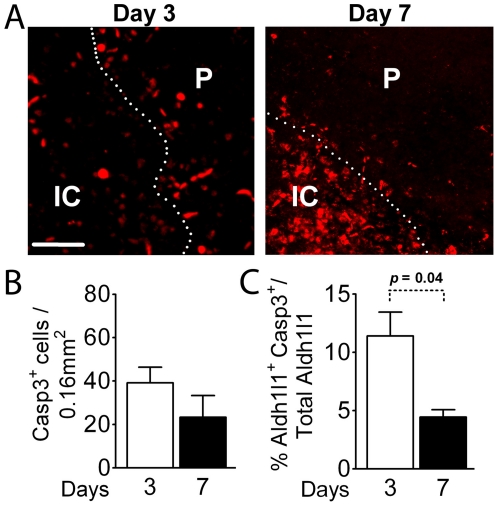
Detection of apoptotic cells in the penumbra.(A) Apoptotic cells identified by staining for cleaved caspase 3 show few apoptotic cells in the core and some in the penumbra on day 3, contrasting with a striking increase in apoptotic cells in the core on day 7. (B) Quantitation of apoptotic cells in the penumbra on days 3 and 7 after injury. (C) A small percent of Aldh1l1 cells are also apoptotic as assessed by caspase 3 activation. The number significantly decreases between days 3 and 7. IC = ischemic core; P = penumbra. N = 3 mice for day 2, N = 5 mice for day 7. Scale Bar, 50 µm.